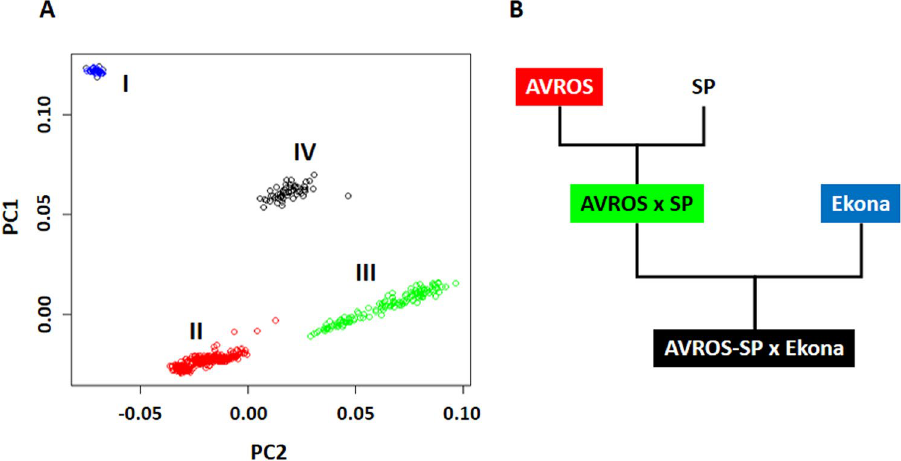
Figure 1. Genetic stratification of 587 oil palm samples, as the first validation set representing four paternal stocks. ( A ) Four clusters i.e. I) Ekona, II) AVROS, III) AVROS x SP, and IV) AVROS-SP × Ekona corresponding to their known origins were detected. PC1 and PC2 indicate the scores of principle components 1 and 2, respectively. ( B ) A pedigree of the four origins. SP – Serdang fertile pisifera